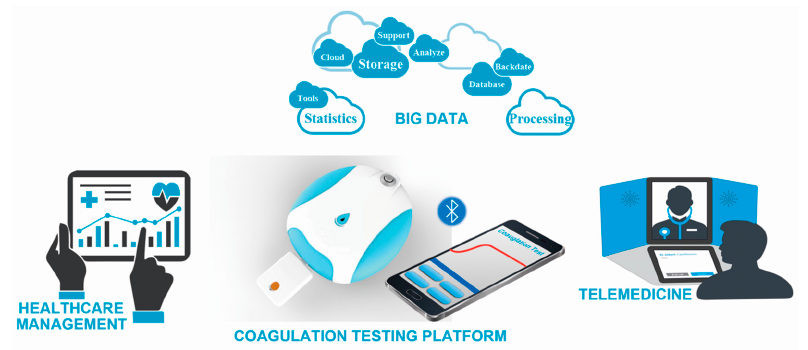
Figure 1. Coagulation testing platform and its functions.